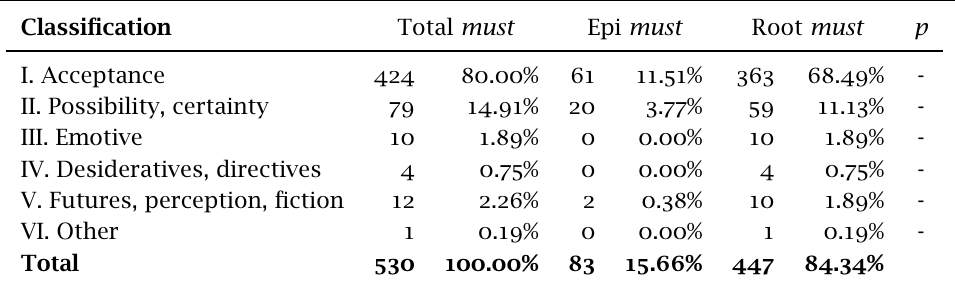
Distribution of epistemic and root must across attitude contexts (random sample): - p > 0 . 05 , Fisher’s exact test. Compares the distribution of epistemic and root must in each class to its distribution by flavor in matrix declaratives ( 17 %